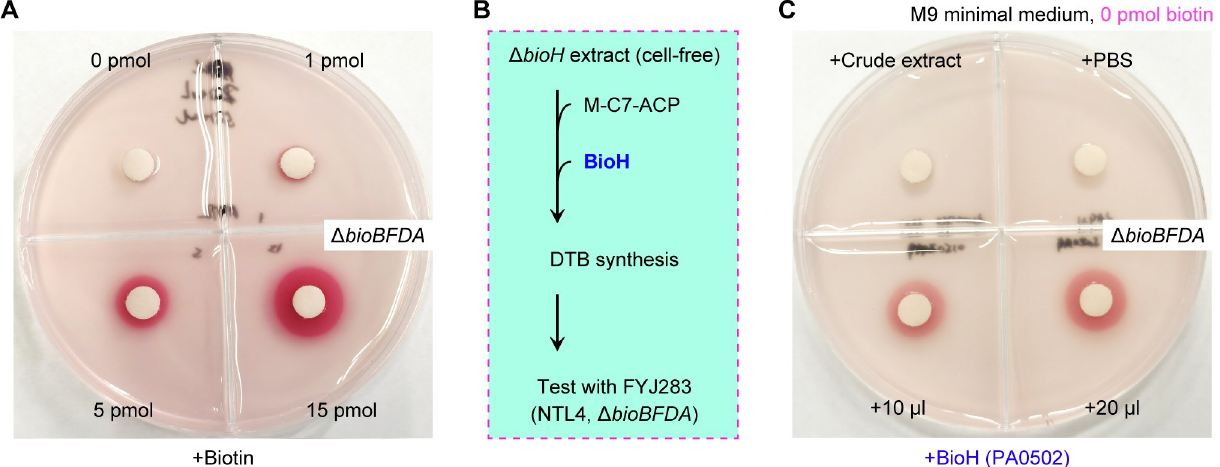
Fig 4. The BioH (PA0502) allows the in vitro reconstitution of biotin synthesis pathway. A. The addition of exogenous biotin allows growth of the biotin auxotrophic strain on non-permissive, biotin-deficient condition of M9 minimal medium. B. Scheme for the in vitro reconstitution of biotin synthesis. C. The PA0502 enzyme enables the reconstitution of biotin synthesis in vitro . The biotin indicator strain used here, is FYJ283 (the Δ bioBFDA mutant of Agrobacterium tumefaciens NTL4). Use of 2,3,5-triphenyl tetrazolium chloride (TTC, 0.001%) proceeds to probe bacterial viability of the Δ bioBFDA mutant. In principle, the occurrence of biotin is verified by the release of insoluble red pigment reduced from TTC that is precipitated to surround viable cells [17]. To prevent biotin cross-contamination, quadrant sectored plates were used, each sector of which is placed with a paper disc to spot biotin and/or DTB/biotin reaction